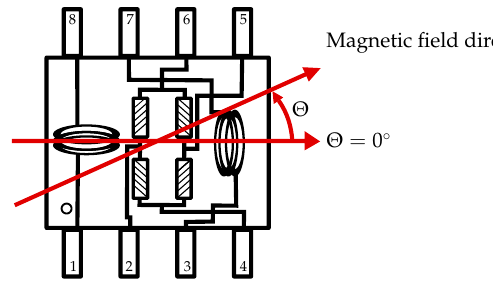
Figure 2. AMR sensor schema referring to